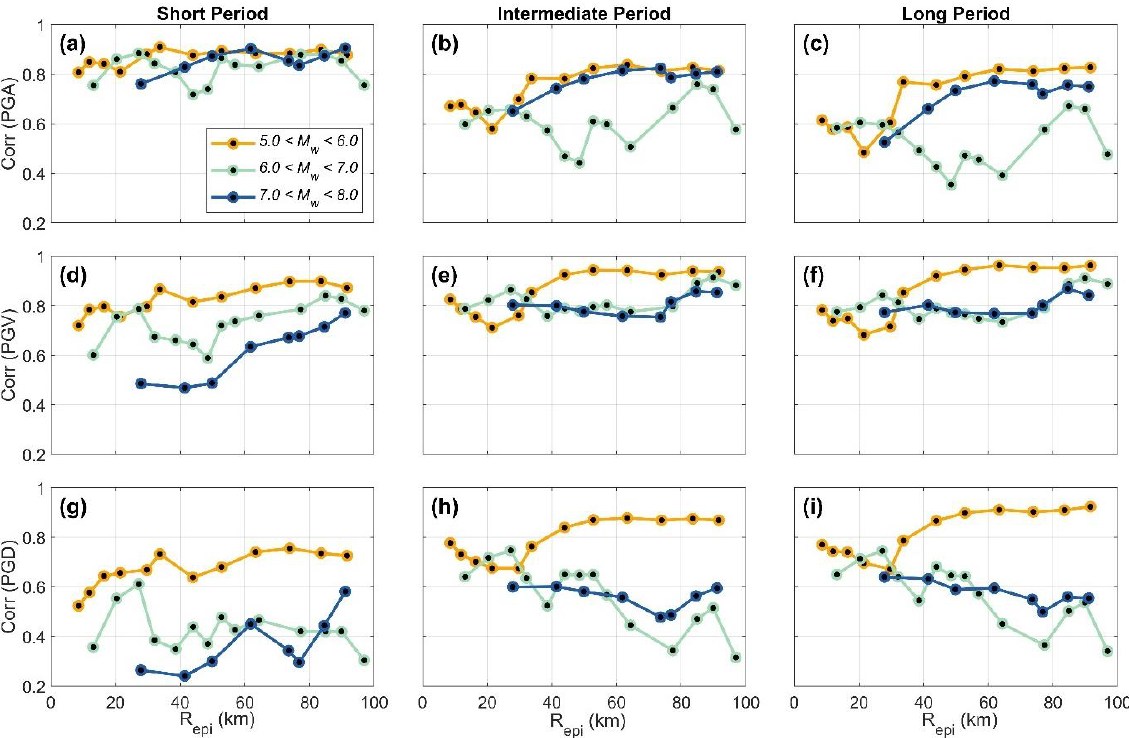
Figure 7. Distance-dependent correlations of peak measures ( PGA , PGV , PGD ) for different magni- tude bins ( M w 5–6, M w 6–7 and M w 7–8) (panels a – i ). Rows correspond to variations in correlations of PGA , PGV and PGD for three different types of structures—short period, intermediate period and long period (SP, IP and LP). Correlations of PGA and PGV are almost invariant for SP and IP/LP structures, respectively (panels a , e , f ). For IP/LP structures, correlations of PGV increase with distance for magnitude bins M w 6–7 and M w 7–8. PGD shows significant distance and magnitude dependence for all types of structures.